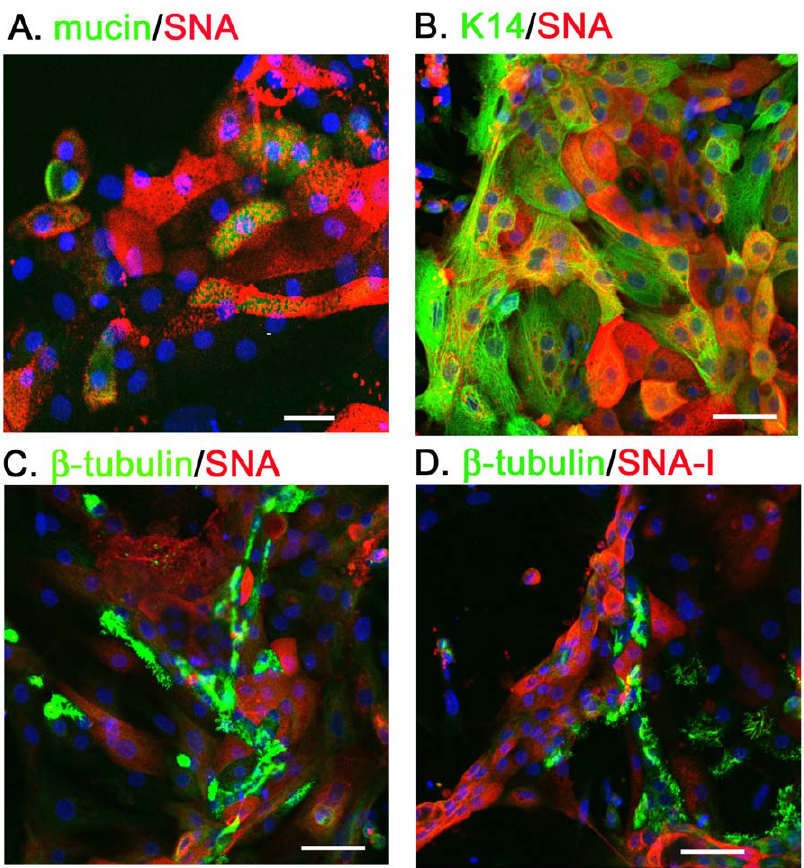
Figure 3. The SA a 2–3Gal and SA a 2–6Gal expression on basal cells. The tracheal basal cell was identified by the expression of K14 (1:100, Convance) (A). Panels (A, B, C) with two fluorescent tags are shown in juxtaposition, illustrating the triple immunocytostaining result in a same field. The arrows in A, B and C indicate cells that are triple-positive for K14, MAA and SNA. The cell nuclei were stained with DAPI (blue). Scale bar, 50 m m.